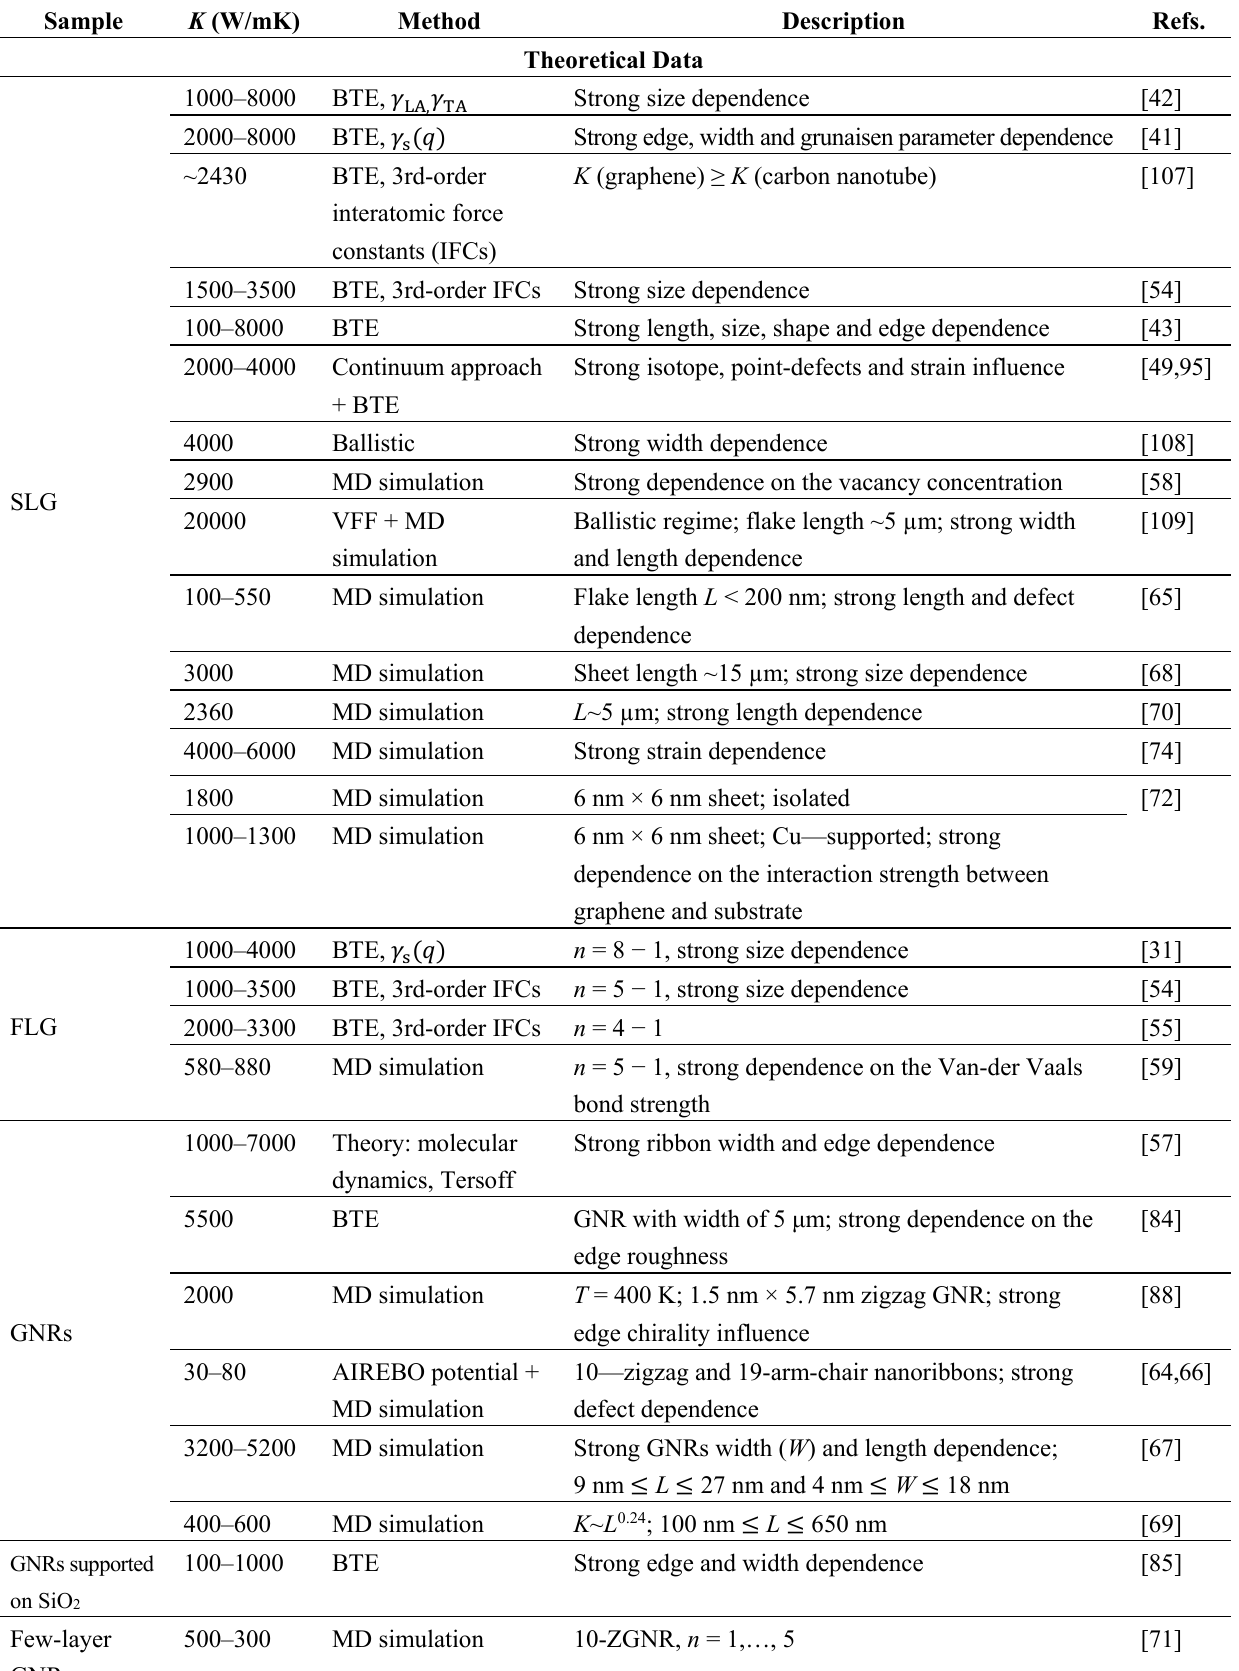
10—zigzag and 19-arm-chair nanoribbons; strong defect